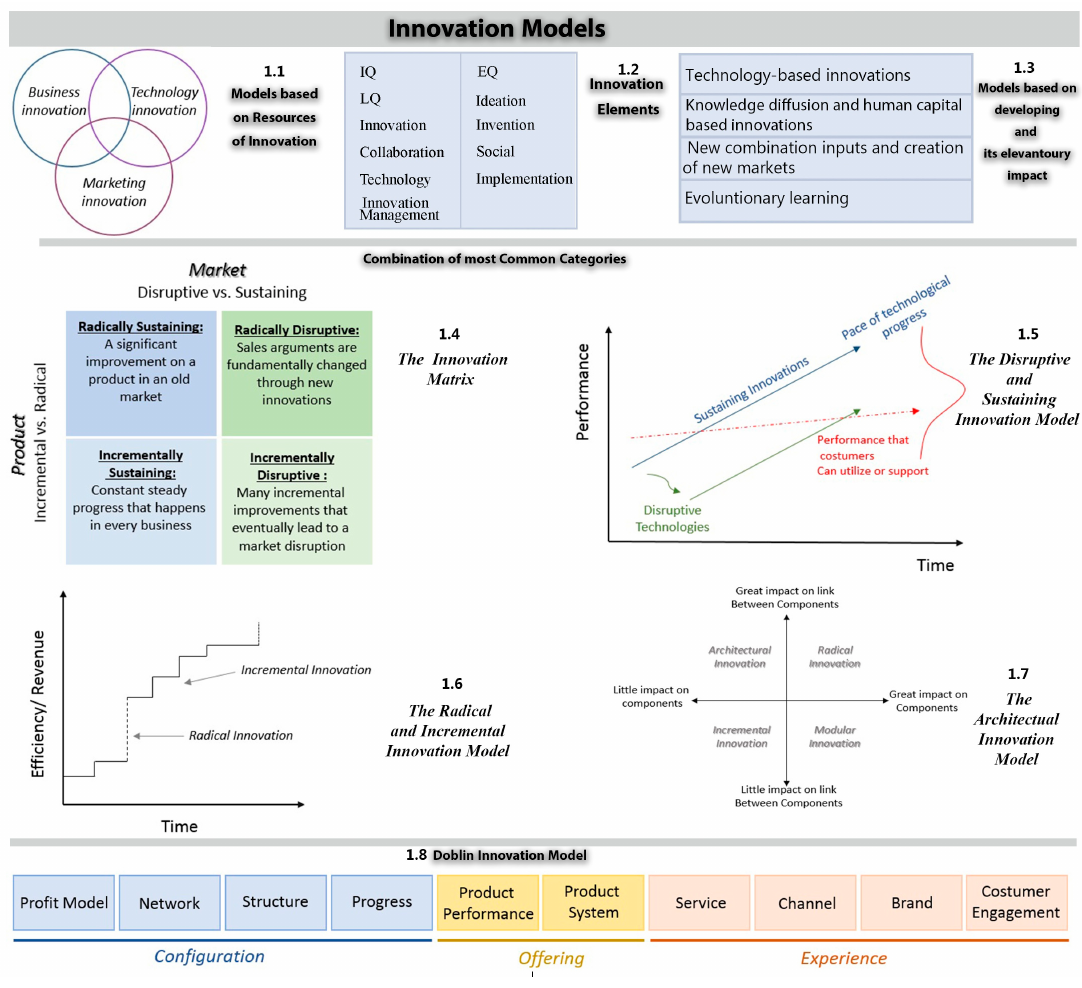
Figure 1. Innovation models [4–6].